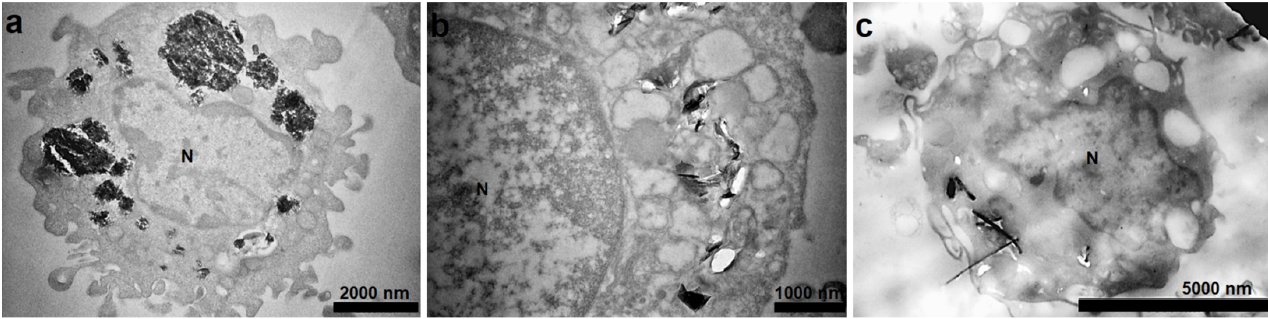
Figure 3. TEM images of intracellular distribution of ( a ) GP1 at 60 μ g/mL, ( b ) GP2 at 60 μ g/mL and ( c ) MWCNTs at 30 μ g/mL after 24 h exposure. N—nucleus.